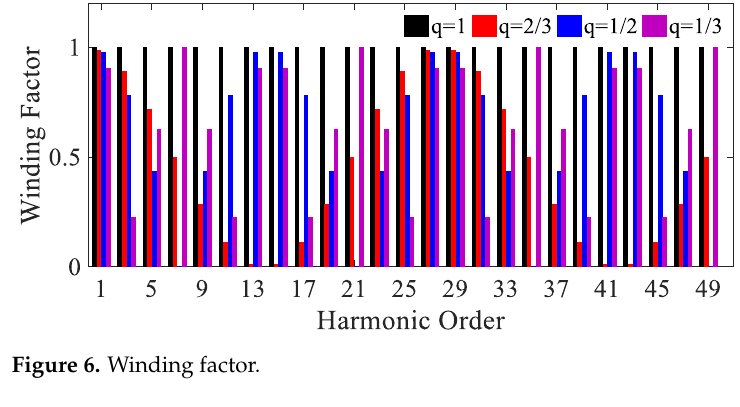
Figure 6. Winding factor.